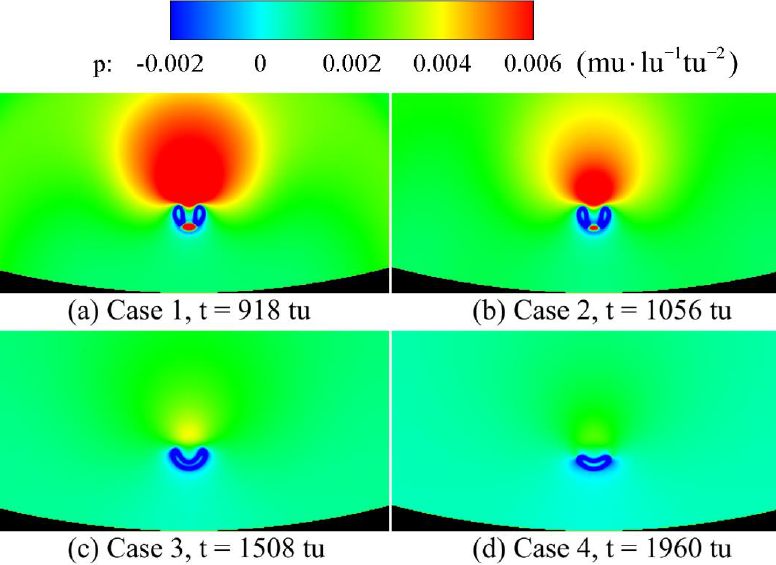
Figure 8. The evolution of pressure at point P in Cases 1–4. Figure 9 shows the evolution process of micro-jet when cavitation-bubble collapse under different additional pressures. In the present study, the measurement of the micro-jet by Plesset and Chapman is adopted [34]. This method can effectively avoid the effect of virtual velocity in the pseudo-potential model by treating the velocity of the bubble wall at the top of the cavitation bubble as the micro-jet velocity. When the additional pressure around the bubble decreases, the velocity of